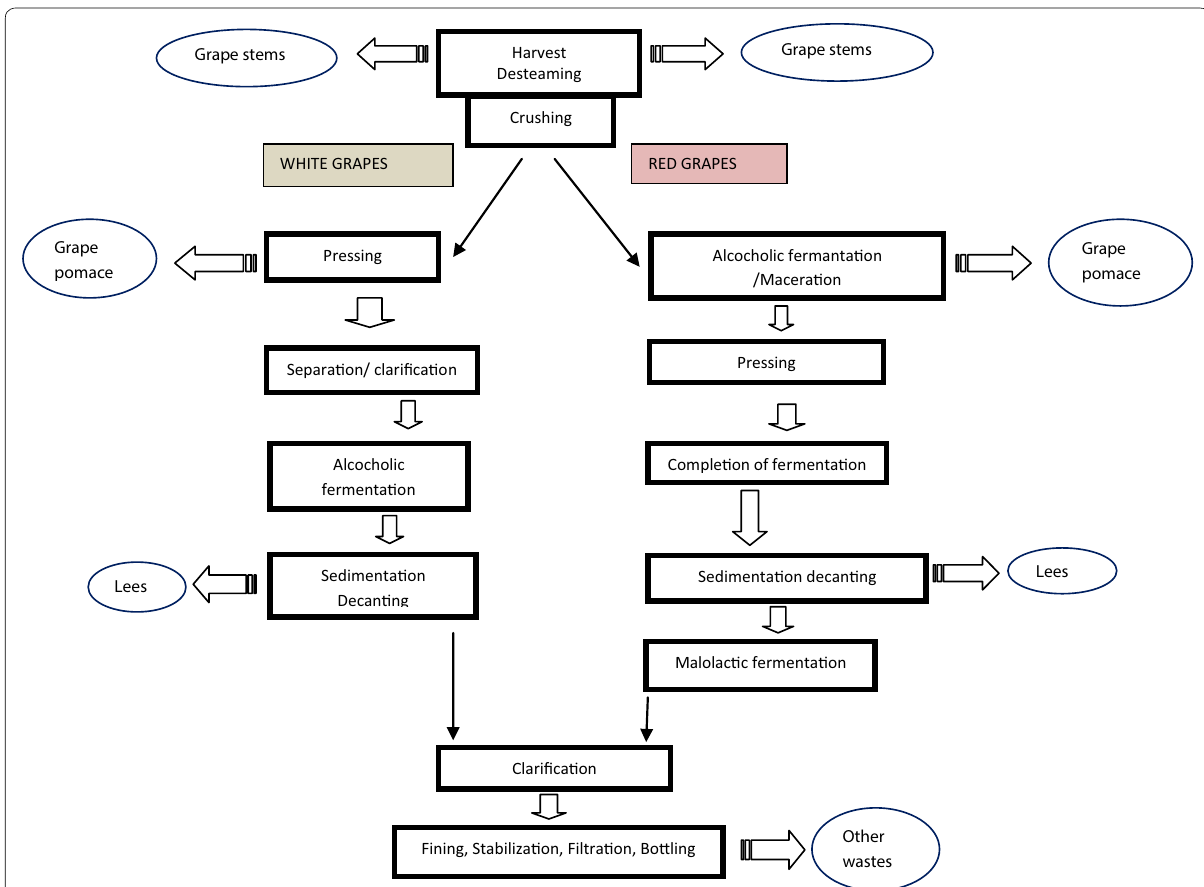
Fig. 1 Grape by-products generation during wine production